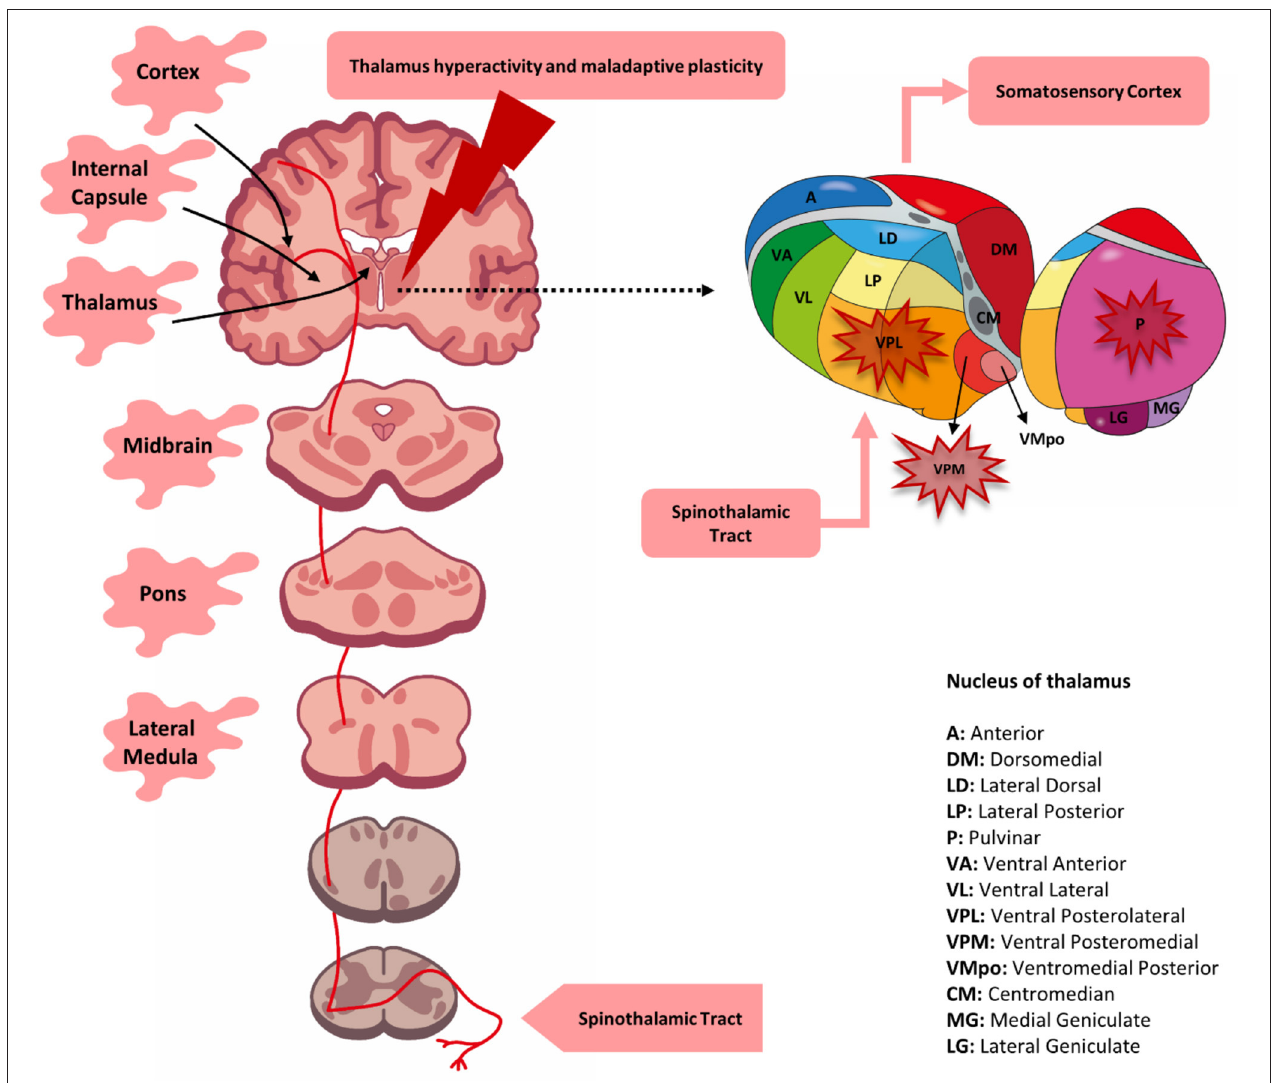
FIGURE 1 | Lesion site associated with central post-stroke pain (CPSP). A lesion located at any level of the spinothalamic tract ( red line ) may be responsible for the development of post-stroke pain. Although, involvement of the thalamus (primarily the ventral posteromedial nucleus, posterolateral nucleus, and possibly the pulvinar nucleus) was initially determined to be solely responsible for pain, it was later determined that lesions of the lateral medulla, pons, lenticulo-capsular, and cortex could also be associated. CPSP is possibly the result of the loss of somatosensory integration along with changes in functional and cortical